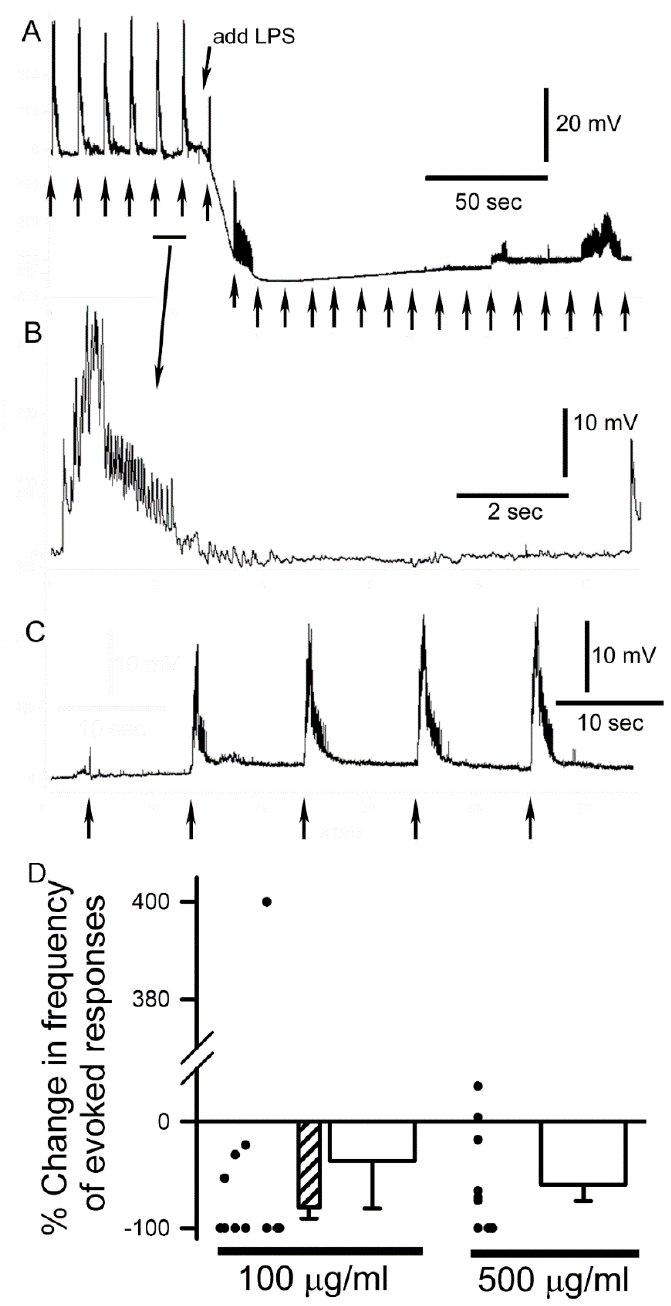
Figure 4. The effect of LPS exposure on the evoked sensory-CNS-motor neural circuit and synaptic transmission at the neuromuscular junction in 3rd instar larvae. (A) The stimulus train delivered to sensory roots every 10 sec before and during LPS exposure evoked a motor nerve recruitment which was indicated by the evoked EJPs measured in muscle 6. Note the enlarged trace shown in (B) of the 5th–6th stimulus train in A above. The muscle membrane potential rapidly hyperpolarized upon exposure to LPS and the amplitude of the EJPs also decreased rapidly. (C) Replacing the saline containing LPS with fresh untainted saline resulted in the evoked EJPs to return and the amplitude of the EJPs to increase as compared to during the LPS exposure. (D) Average percent change in EJP frequency in response to 10 min of LPS exposure for 100 µg/mL and 500 µg/mL. The mean (±SEM) percent changes are shown as bars along with the changes in the individual preparations. The individual preparations are offset from each other in order to prevent overlap. The outlier at 400% increase for the 100 µg/mL was removed for additional analysis of a mean (±SEM) as seen in the hatched bar graph.